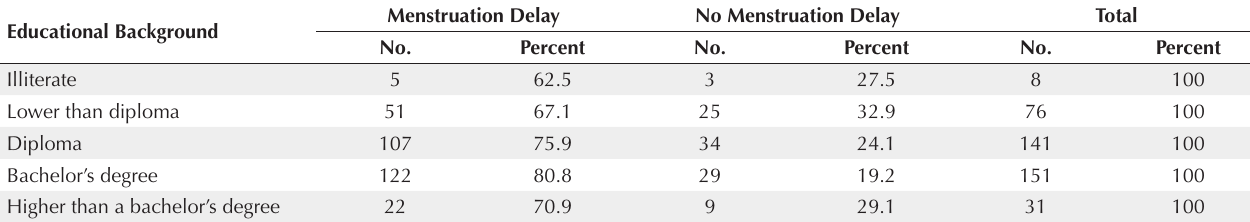
Table 3. Comparison of Delay in Menstruation and Educational Background Educational